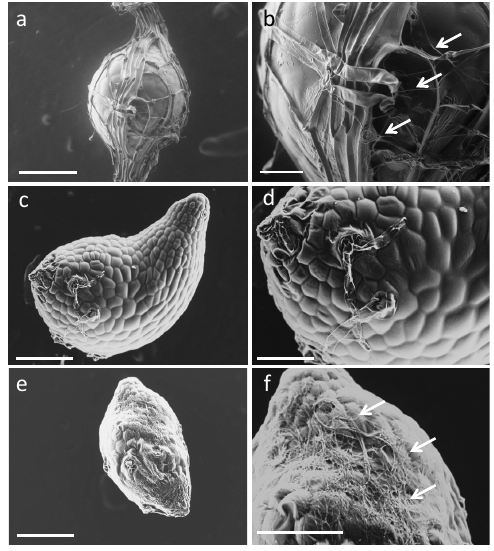
Figure 3. Scanning electron microscopy (SEM) images of one-week-old Bletilla striata protocorms inoculated with the symbiotic fungus Sebacina vermifera . ( a , b ) Intact seed with seed coat retained, ( c , d ) intact seed with peeled off just before observation, and ( e , f ) a seed coat-stripped seed. Arrows indicate fungal hyphae. Scale bars, 200 µm ( a , c , e ), 50 µm ( b ), and 100 µm ( d , f ).